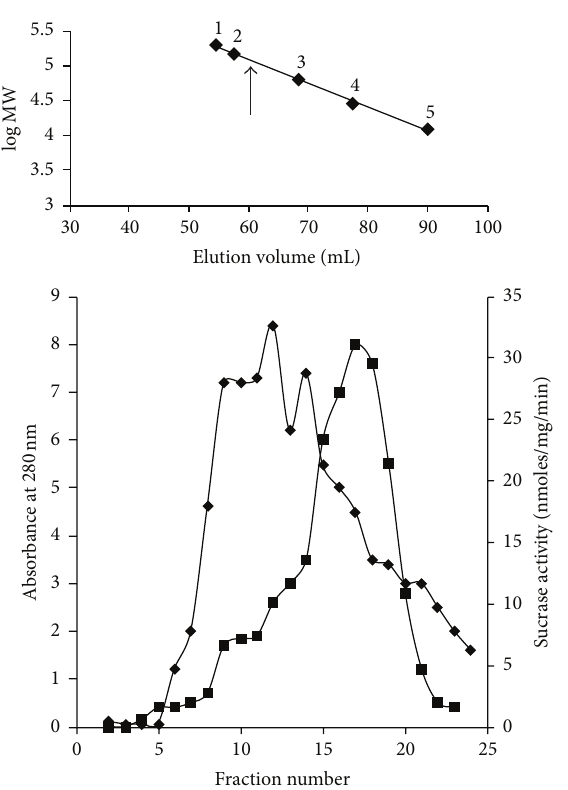
Figure 1: Size-exclusion chromatography of intracellular sucrase. The ammonium sulfate saturated sample protein was run on a Sephacryl (S-200) column, preequilibrated with Buffer A. The protein absorbance measured at 280 nm (- X -) was plotted on primary axis. The secondary 𝑦 -axis shows the intracellular sucrase activity (- ◼ -) of the corresponding fractions. The molecular weight of the native enzyme was determined to be ∼ 112kDa from the S-200 calibration graph (Figure 1 inset). The ↑ arrow indicates the peak of intracellularsucraseelutionvolumeandthemolecularweight(MW) of the protein. The molecular weight markers used were as follows: amylase MW = 200,000; alcohol dehydrogenase MW = 150,000; hemoglobin MW = 64,500; carbonic anhydrase MW = 29,000; and cytochrome C MW =